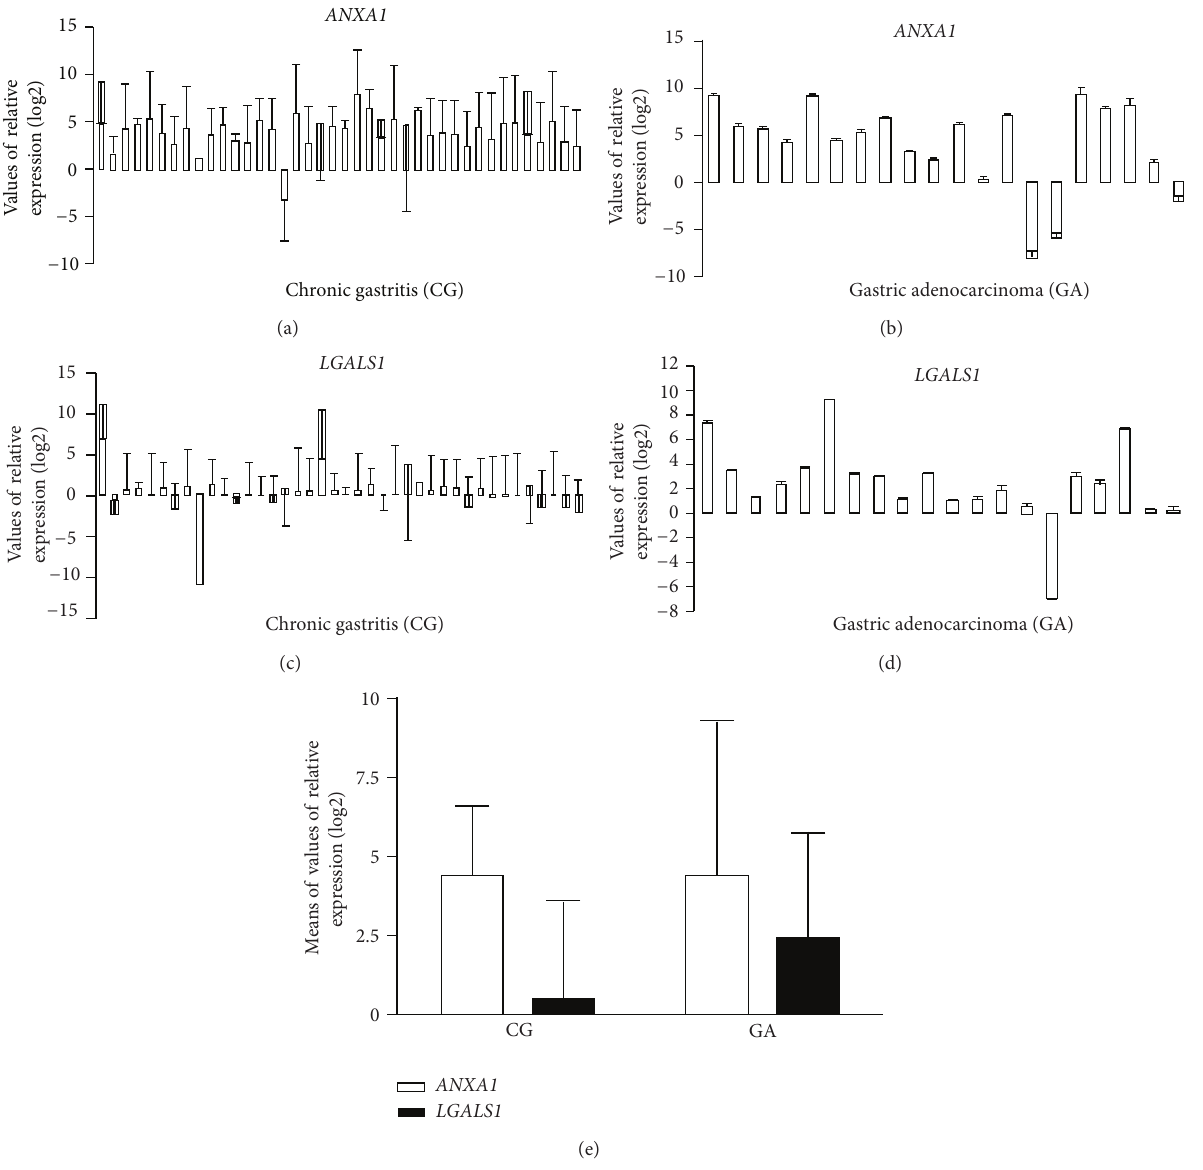
Figure 1: Values of relative gene expression (log2) of ANXA1 (a, b) and LGALS1 (c, d) and means of values of relative gene expression (e) in the chronic gastritis (CG) and gastric adenocarcinoma (GA)